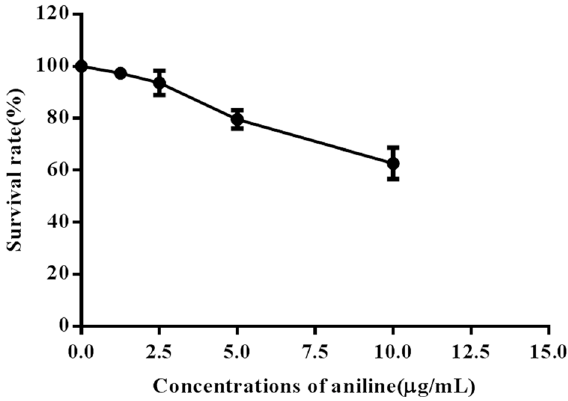
Figure 5. Viability of hepatocytes exposed to aniline. Hepatocytes were cultured in the absence or presence of 1.25, 2.5, 5.0 or 10.0 μ g/mL aniline for 24 h. Cell viability was determined based on the